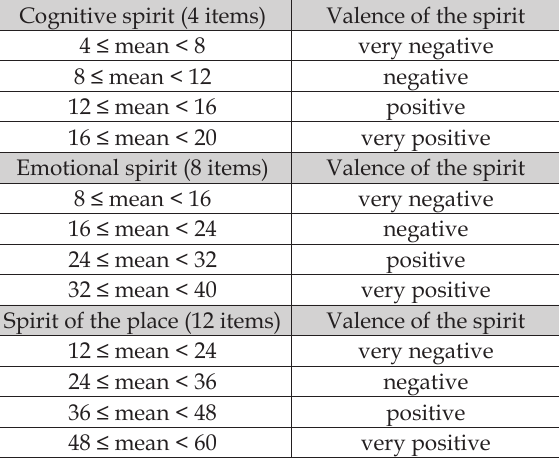
Table 3. The valence scores for the three spirits.